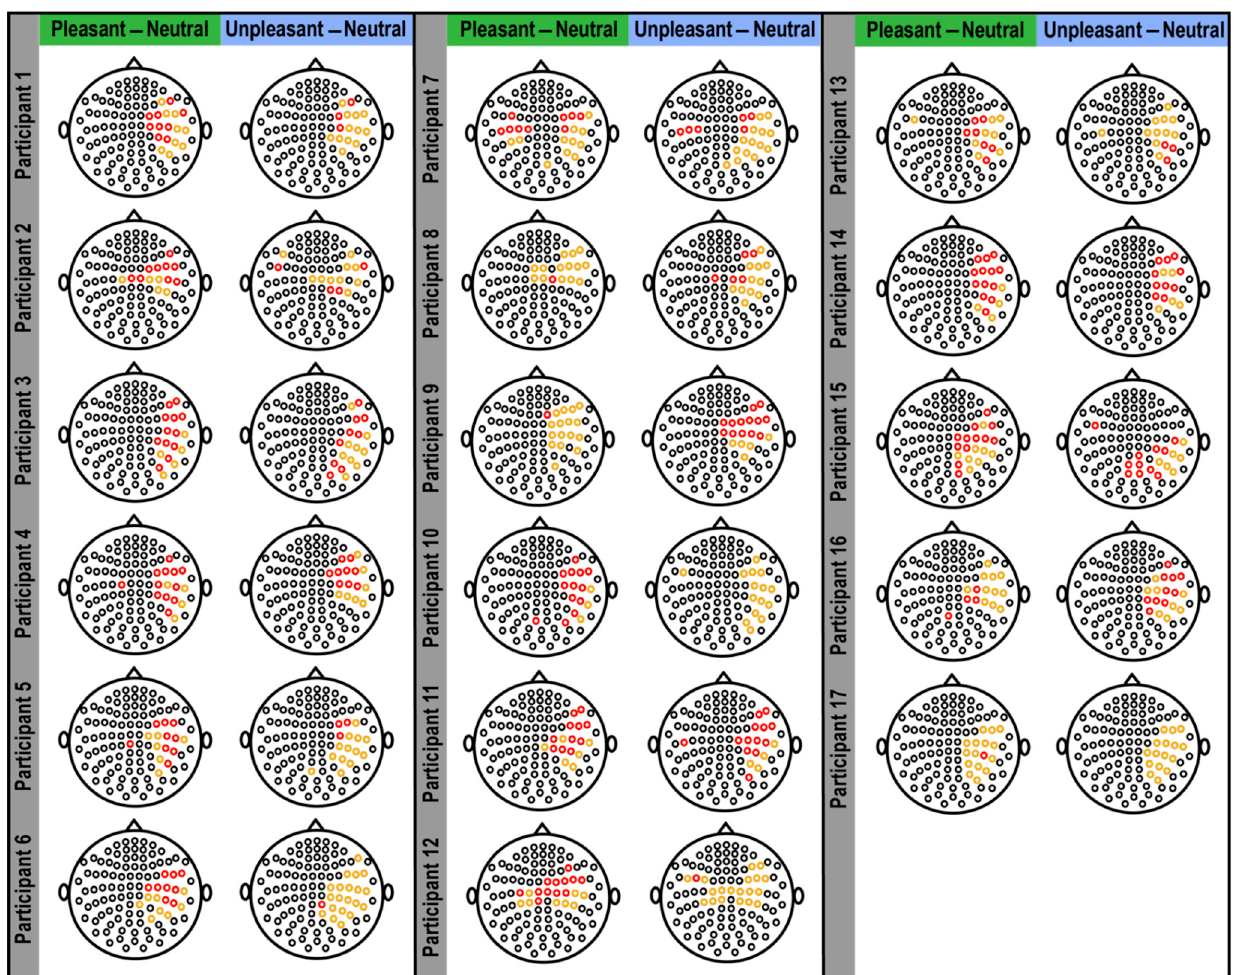
Figure 3. Selected sensors showing the highest differences in brain responses to pleasant and unpleasant versus neutral pictures for each participant. The plots depict the magnetoencephalography (MEG) sensors across the entire head (small black circles). Highlighted sensors (in orange and red) indicate the sensors selected by bootstrapping, showing the largest differences in brain response to pleasant and unpleasant versus neutral pictures for each participant. The highlighted orange sensors are those that were selected by more than 20% of bootstrapping replications, and the red sensors are those that showed significantly higher responses to high-arousing emotional pictures versus neutral pictures within 20% of bootstrapping replications.